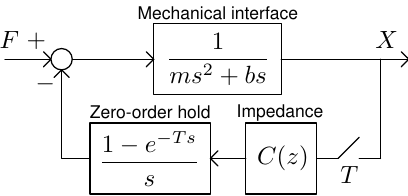
Figure 1. Block diagram of the haptic